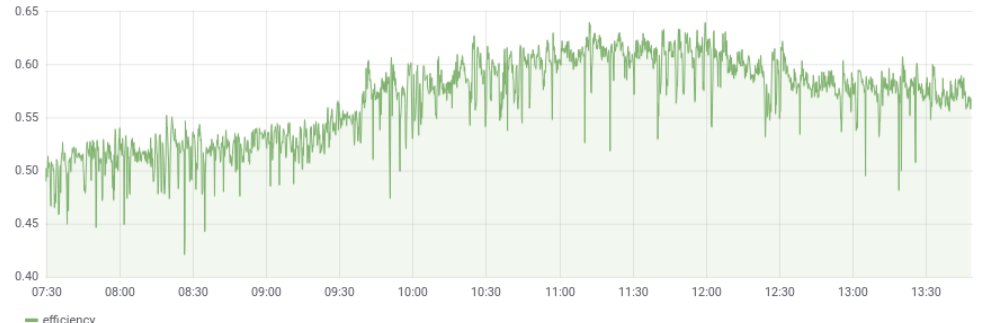
Figure 12. Collector instantaneous efficiency ( n )